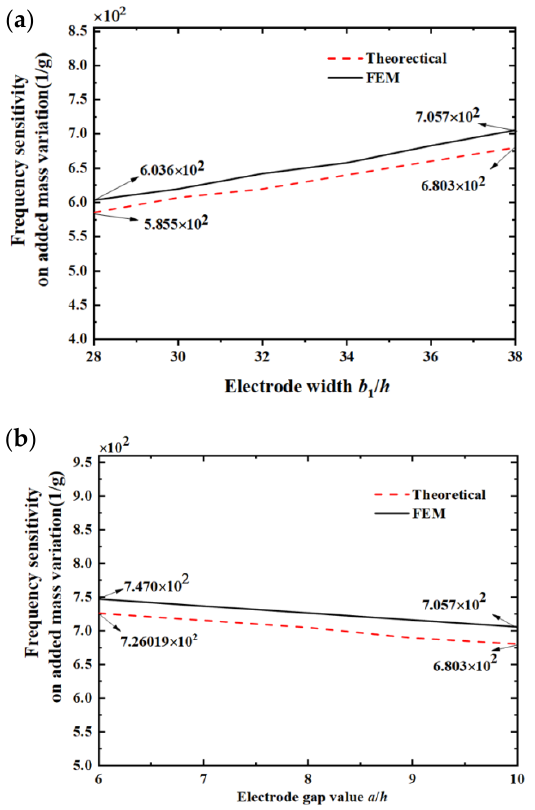
Figure 9. Frequency sensitivities on added mass vs. electrode parameters. ( a ) Electrode width b 1 . ( b ) Electrode gap a .